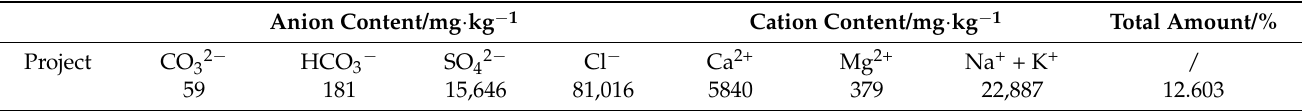
Table 7. Soil quality analysis of saline soil.